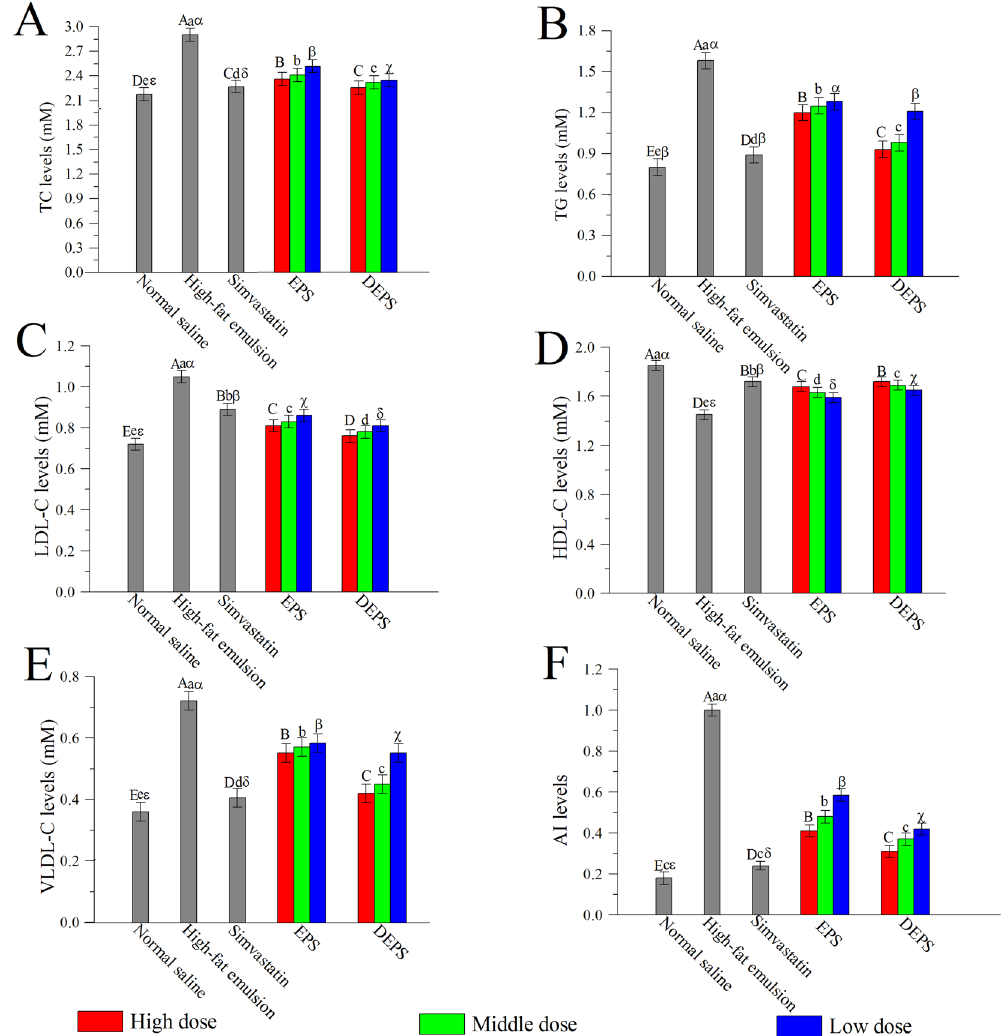
Figure 2. Effects of EPS and DEPS on serum lipid profiles in hyperlipidaemic mice: TC ( A ), TG ( B ), LDL-C ( C ), HDL-C ( D ), VLDL-C ( E ) and AI ( F ). The values are reported as means ± SD (n = 10). Bars with different letters are significantly different ( P <